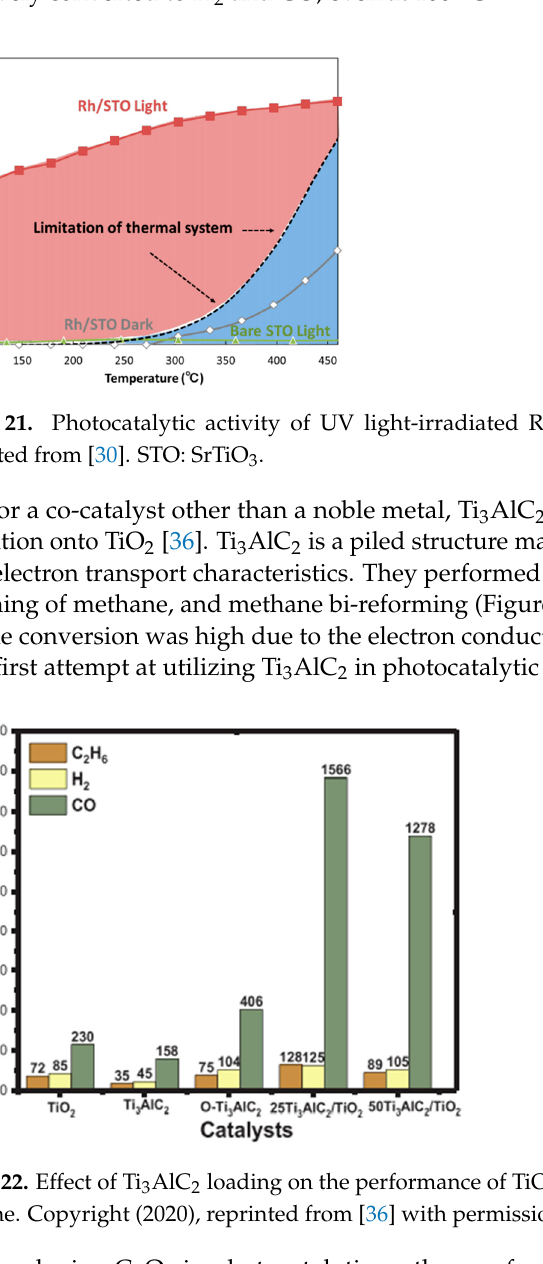
Figure 20. ( A ) Phosphorescence exciting spectra of MgO. ( B ) Time course of the CO yield and CH 4 consumption over MgO. Reprinted with permission from [44]. Copyright (2004), American Chem- ical Society.